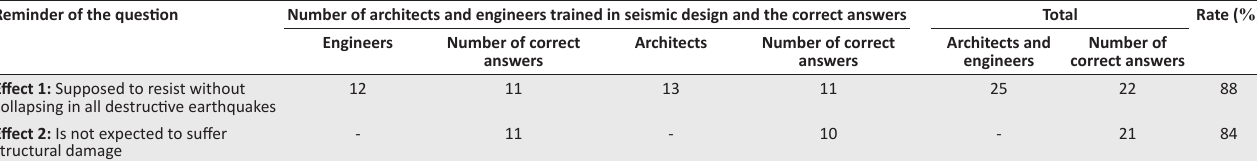
TABLE 13: Seismic training and correct answers for the resistance of buildings to earthquakes. Reminder of the question